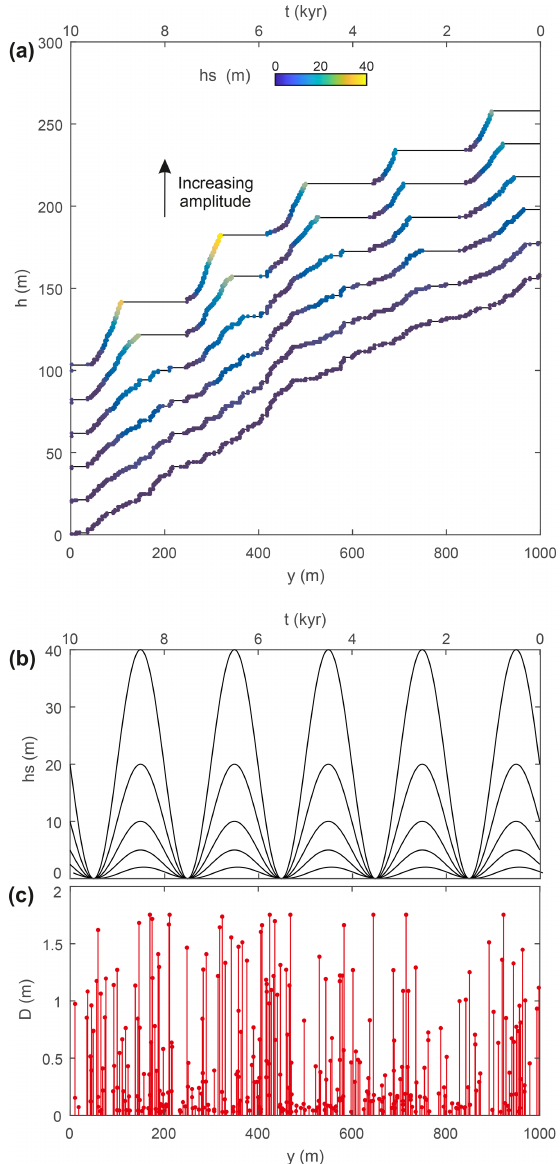
Figure 9. Impact of the rate of sediment aggradation and fault burial on river profile. (a) River profile simulated with sinu- soidal temporal variations for sediment cover, mimicking climatic changes, with a periodicity of 2000 years, and an amplitude of 0, 1, 2.5, 5, 10 and 20m. River profiles are indicated with black lines and the sediment cover thickness at the time of knickpoint formation is indicated by the colour of the points. (b) Time evolution of the sed- iment cover h s for the different simulations presented in panel (a) . (c) Co-seismic displacements D at the location of the river as a func- tion of time t for each model. For panels (a) , (b) and (c) , the x axis indicates both the distance y along the river and the correspond- ing time t , to visually relate fault displacement, sediment cover and river profile. Time and distance along the river are related through the knickpoint retreat rate, V R = y t